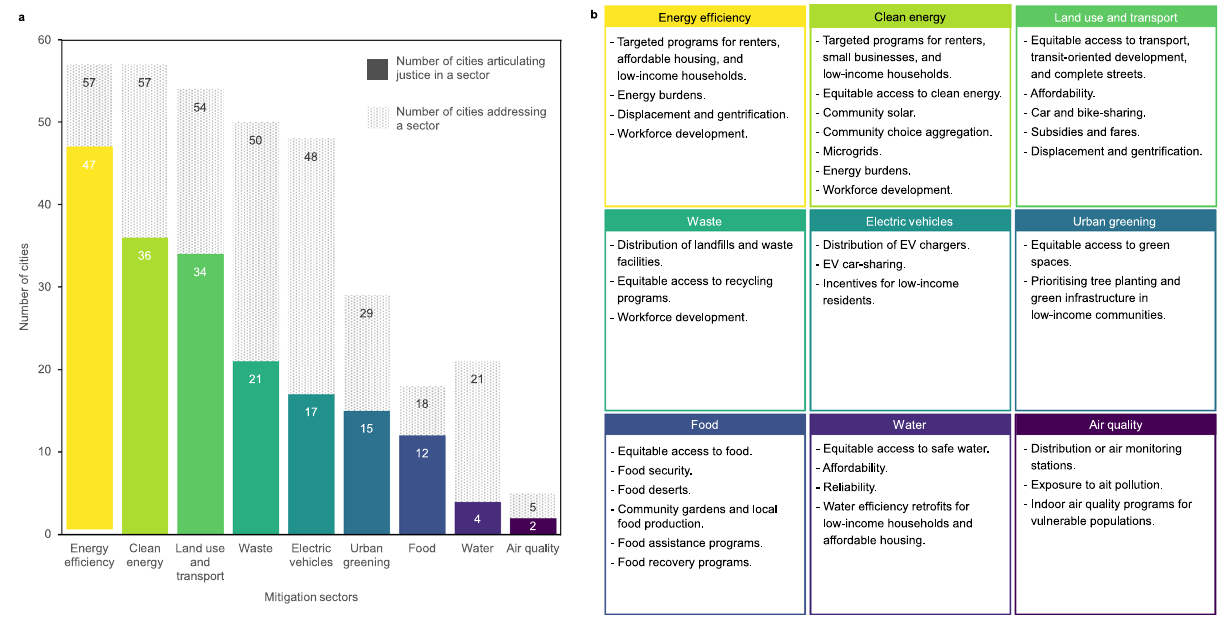
Fig.2|Attentiontoclimatejusticebymitigationsectors.a Numberofcitiesthat articulatejusticeineachmitigationsector.Thedottedpatternrepresentsthetotal number of cities that address each sector as a mitigation strategy within their